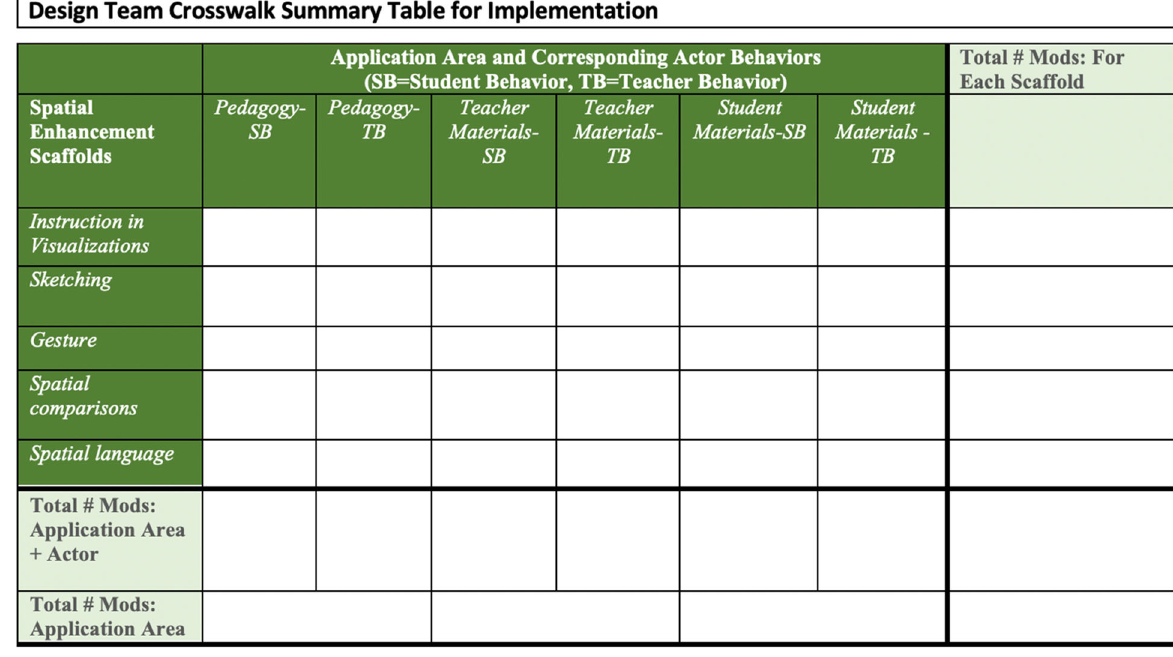
Fig. 6 Design Team Crosswalk Summary